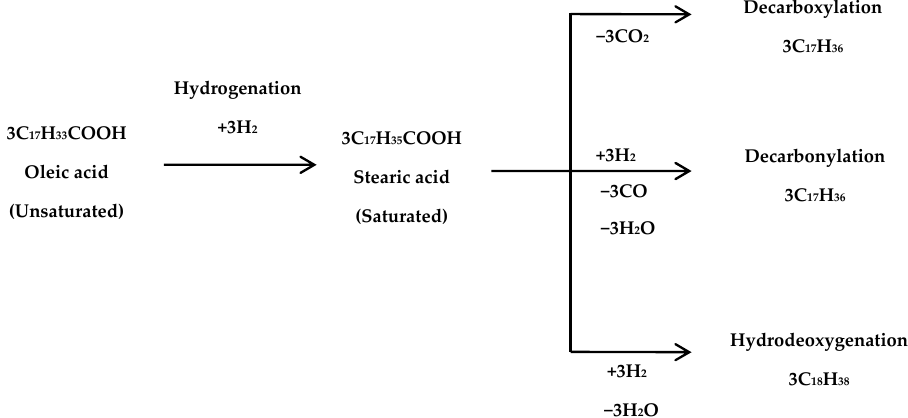
Figure 6. Simultaneous reactions of decarboxylation, decarbonylation, and hydrodeoxygenation of oleic acid.